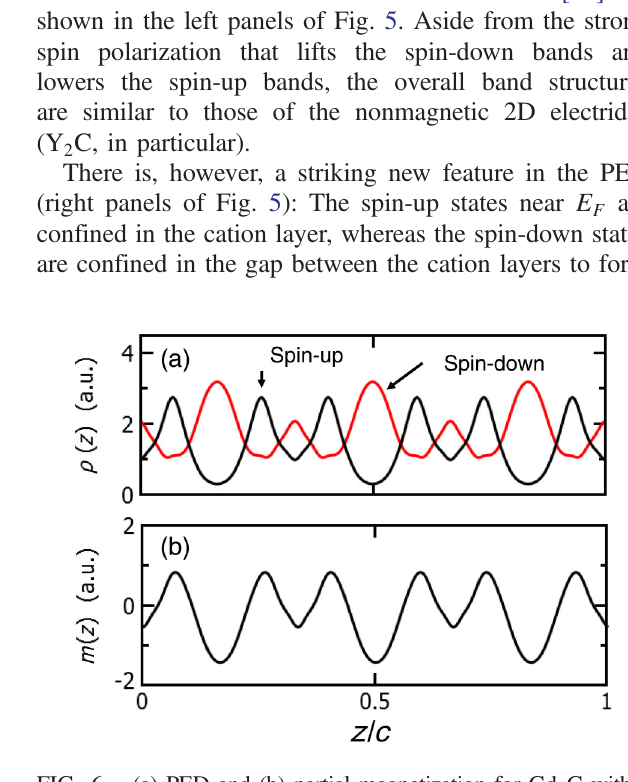
FIG. 6. (a) PED and (b) partial magnetization for Gd 2 C within 0.05 eV of E F averaged over the ab plane ( U − J ¼ 6 eV, J ¼ 0 . 7